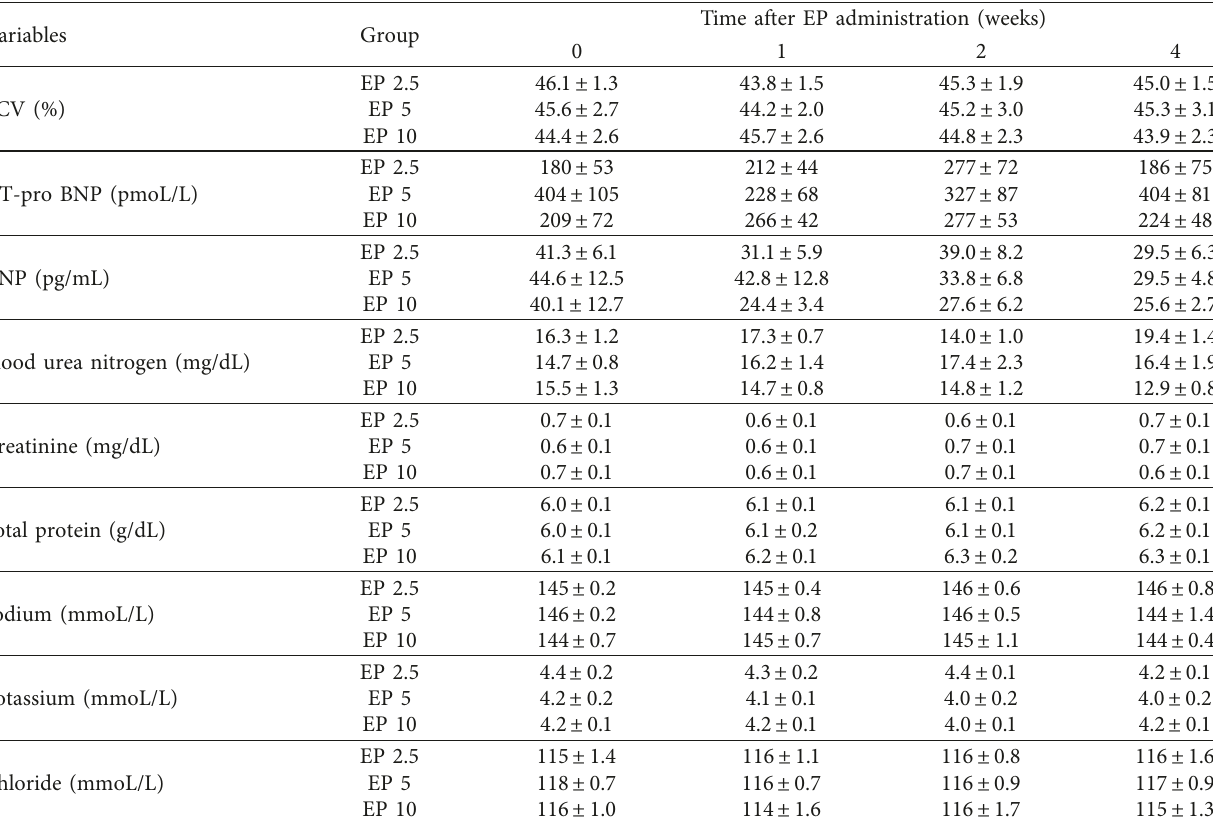
Table 4: Blood paced cell volume (PCV), serum N-terminal pro-brain natriuretic peptide (NT-pro BNP), plasma atrial natriuretic peptide (ANP), blood urea nitrogen, creatinine, total protein, sodium, potassium, and chloride after eplerenone (EP) administration in dogs.